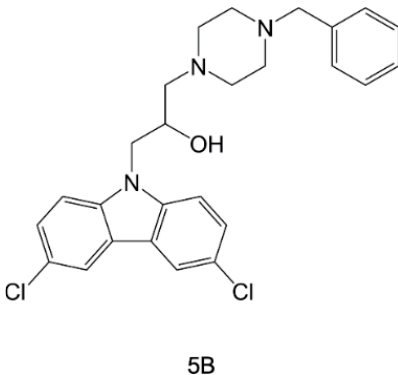
Figure 13. Chemical structure of 5B [114,115].